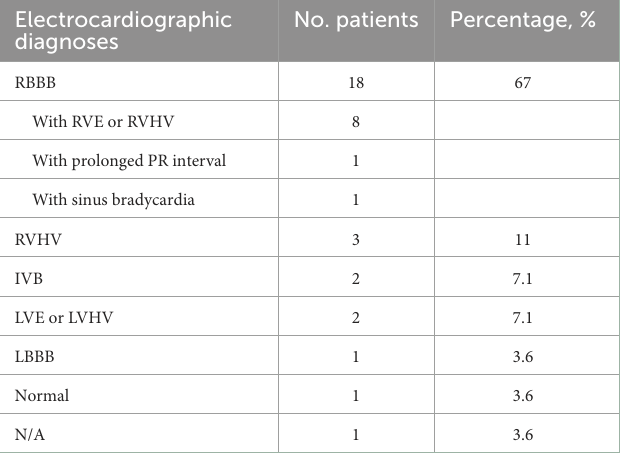
TABLE 2 Preoperative electrocardiograms of patients.